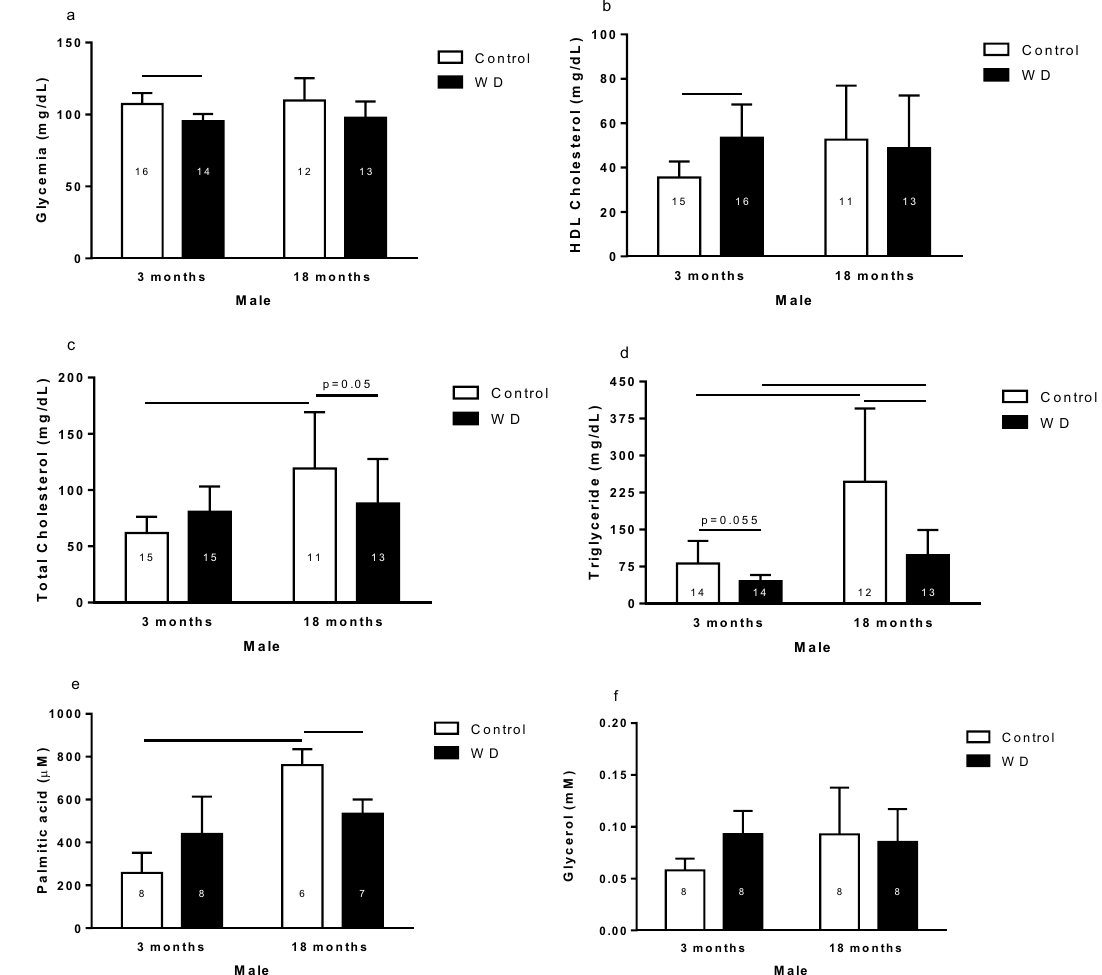
Figure 1. Glycemia ( a ), HDL cholesterol ( b ), total cholesterol ( c ), triglyceride ( d ), palmitic acid ( e ), and glycerol ( f ) of 3- and 18-month-old male control and rats with water deprivation (WD). Data are presented as means (SD), p < 0.05 among the indicated groups. Two-way ANOVA followed by Newman-Keuls or Duncan post-test when variances were equal, and Games-Howell when variances were different. The n for each group is inside the